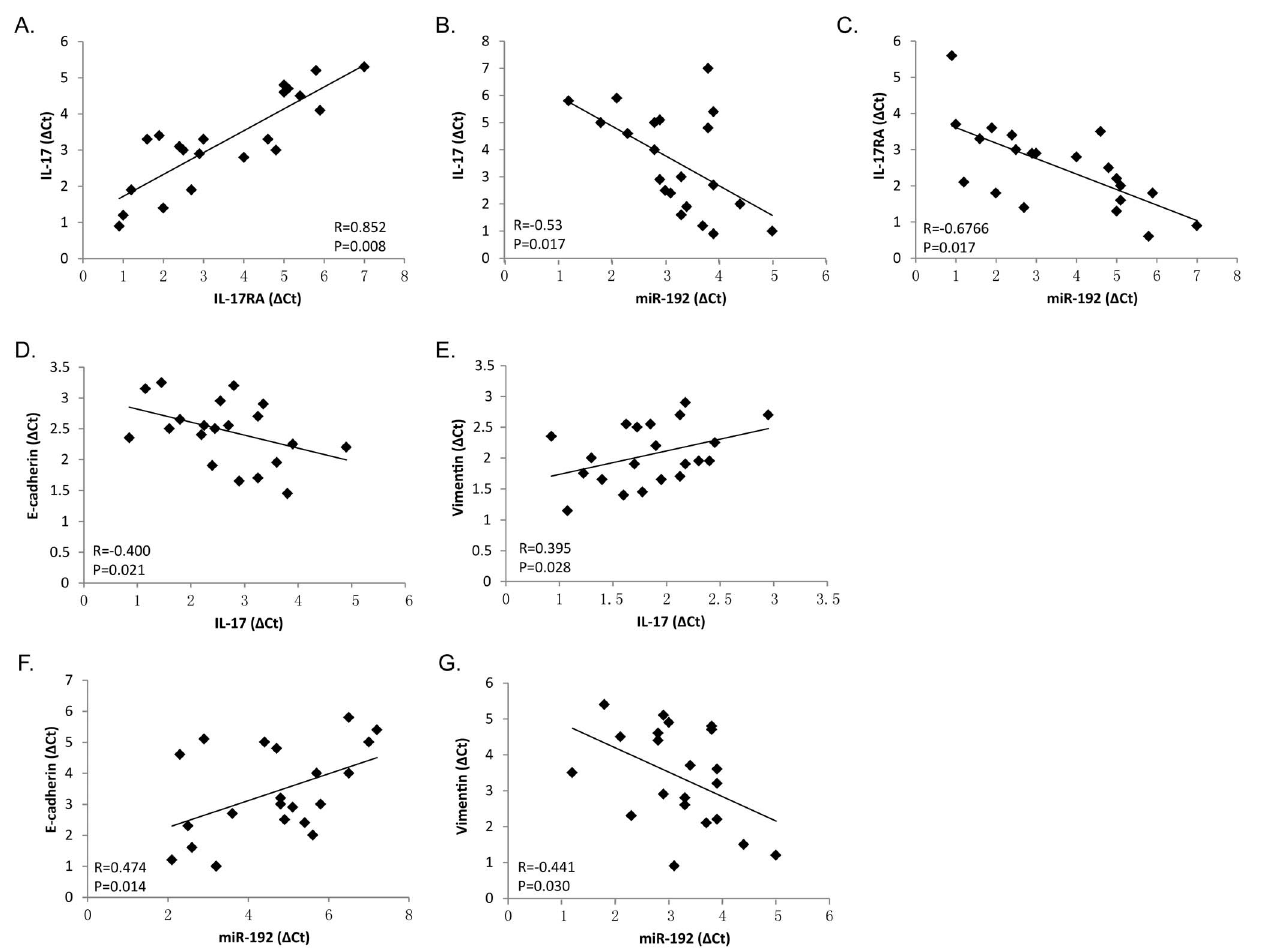
Fig. 6. The IL-17/miR-192/IL-17Rs feedback loop is characteristic for MM. Correlative analysis of the indicated mRNAs and miR-192 in bone marrow tissues of patients with MM was detected by qPCR. Spearman correlation coefficient with the respective significance was